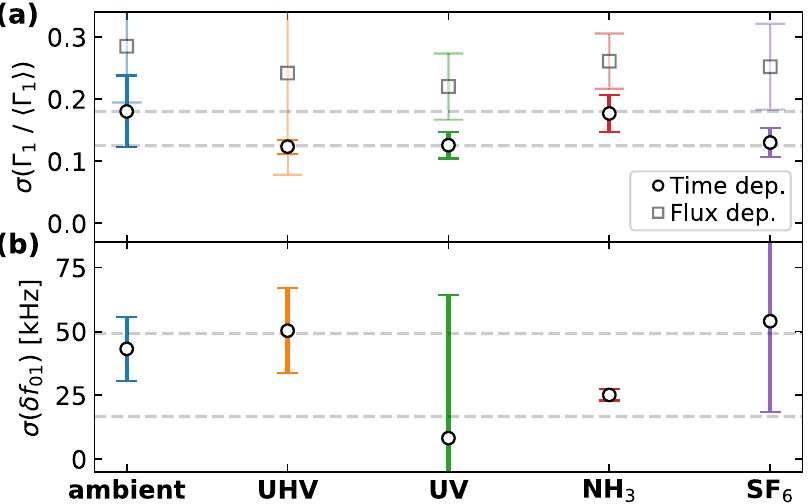
Fig. 4 Low-frequency noise parameters. Width of the median distribution of the relative fl uctuations in Γ 1 / 〈 Γ 1 〉 ( a ) and of the frequency fl uctuations (circle) and fl ux-dependent fl uctuations (square), where the latter was fl uctuations δ f 01 ( b ). Panel a shows time-dependent extracted from data similar to Fig. 2b. Error bars denote ± one median absolute deviation of the distribution of widths. Dashed lines are guides to the